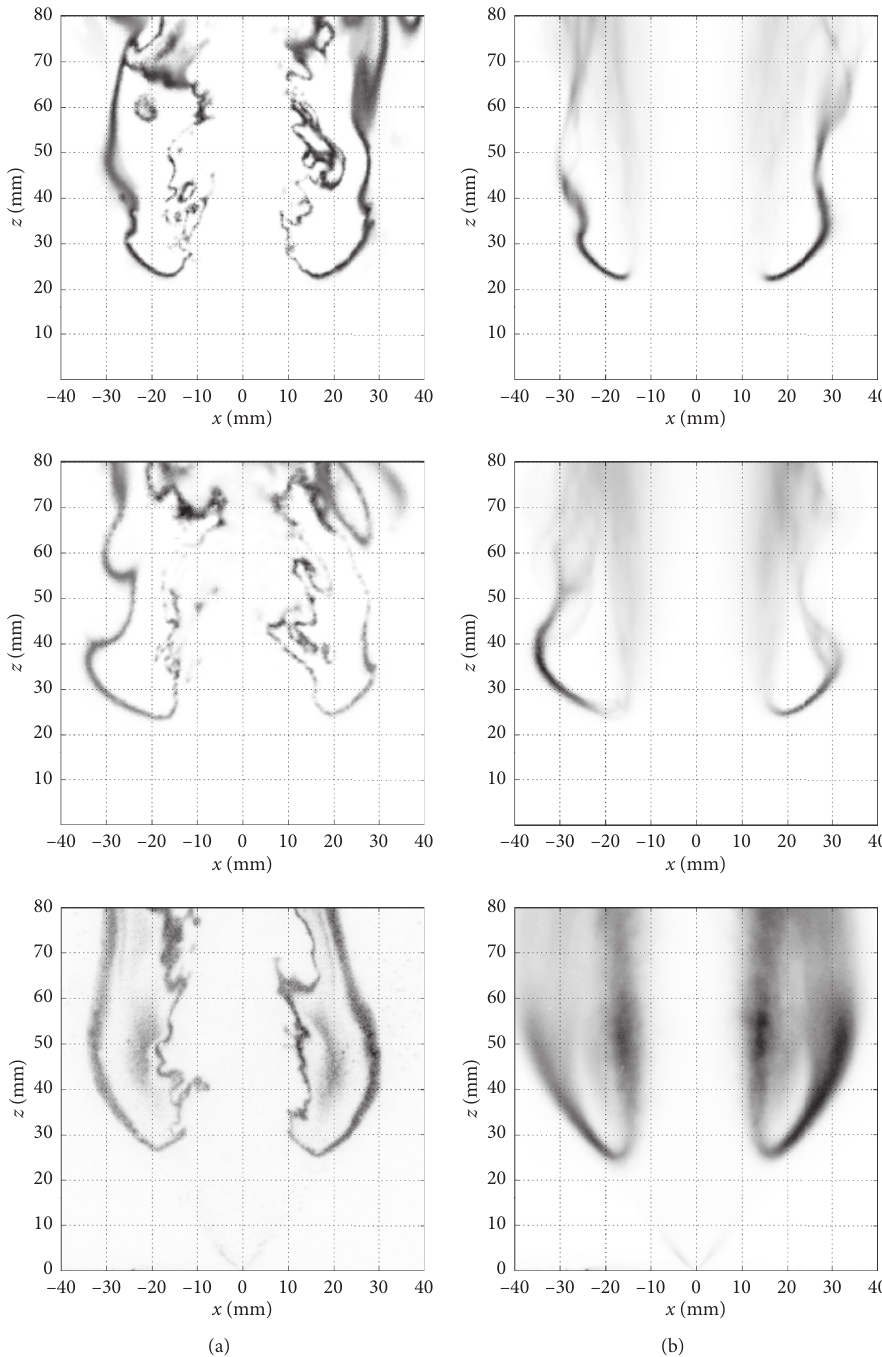
Figure 14: Normalized OH mass fraction (Case A top, case B middle). Experiments (bottom): OH-PLIF, from [19]. (a) Instantaneous signal, (b) mean